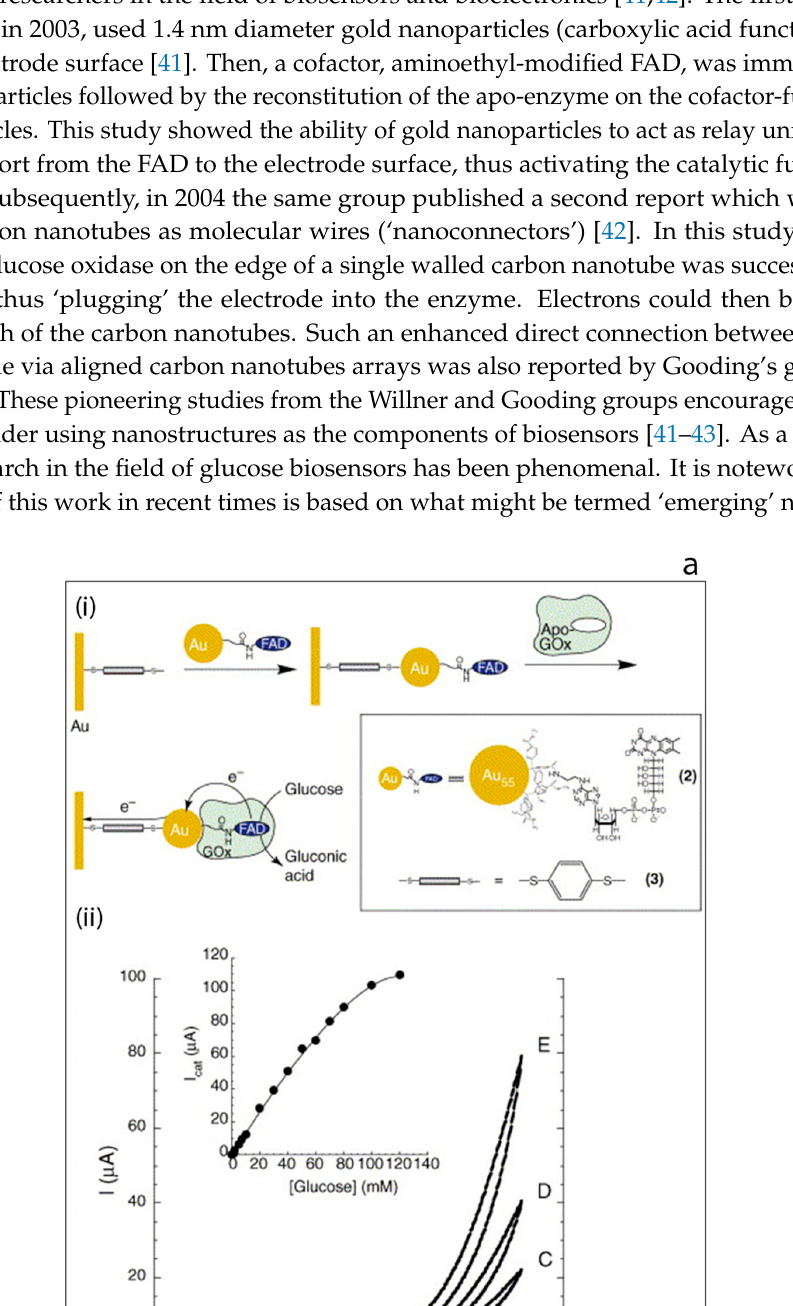
Figure 4. ( a ) Electrical wiring of glucose oxidase: (i) electrical contacting of glucose oxidase by reconstitution of apo-GOx on FAD-functionalized gold nanoparticles linked to an electrode surface by dithiol bridges, (ii) cyclic voltammograms obtained by the developed modified electrode in the presence of different glucose concentrations [37]. ( b ) Schematic image of the surface modification of gold electrode based on self-